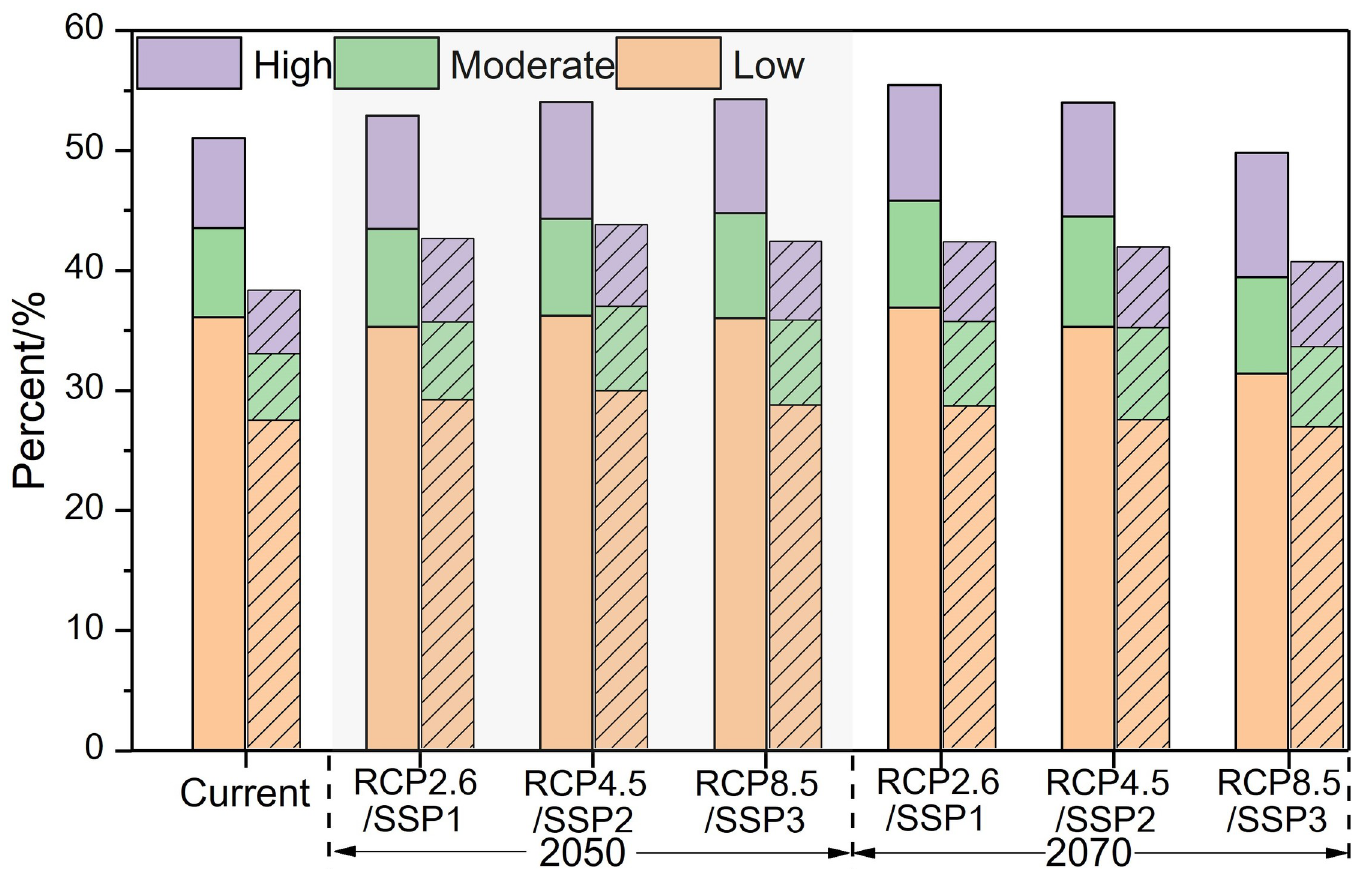
Fig 5. The DF risk area proportion of the climatic model and C&S model in the PRD. The left represents the climatic model. The right represents the C&S